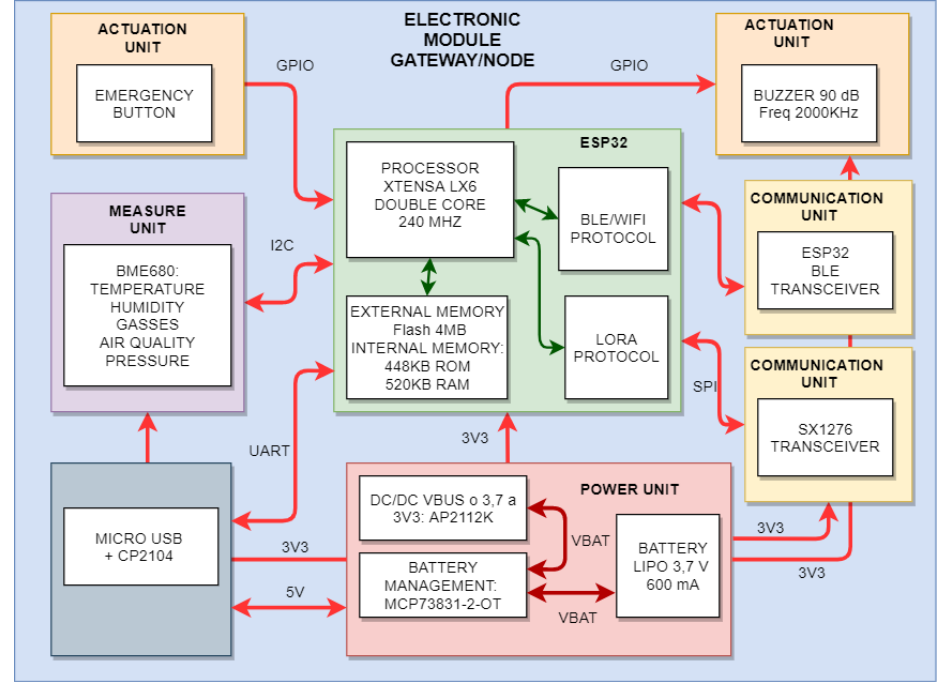
Figure 6. Diagram of node/gateway electronics based on